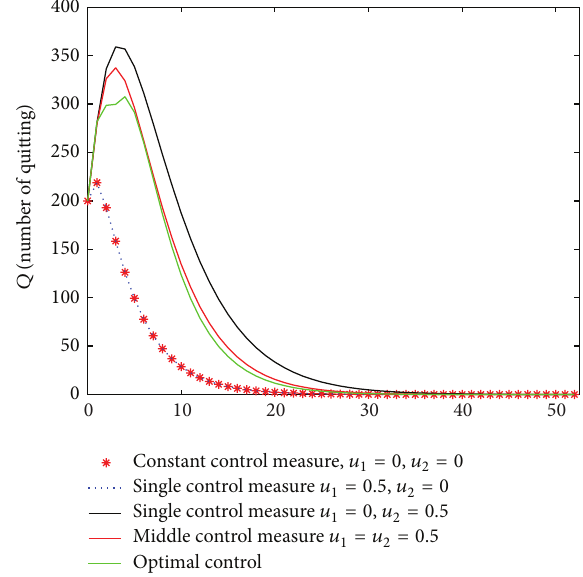
Figure 14: Number of people in quitting compartment when we choose the weights in objective function are 𝑐 1 = 10 4 , 𝑐 2 = 10 2 and underdifferentoptimalcontrolstrategies,thatis,(1)withoutcontrol: = 𝑢 = 0 ; (2) single control: 𝑢 = 0.5 , 𝑢 = 0 ; (3) single control: 𝑢 1 2 1 2 = 0 , 𝑢 = 0.5 ; (4) middle control: 𝑢 = 𝑢 = 0.5 ; (5) optimal 𝑢 1 2 1 2 control: 𝑢 1 = 𝑢 ∗ 1 , 𝑢 2 = 𝑢 ∗ 2 .